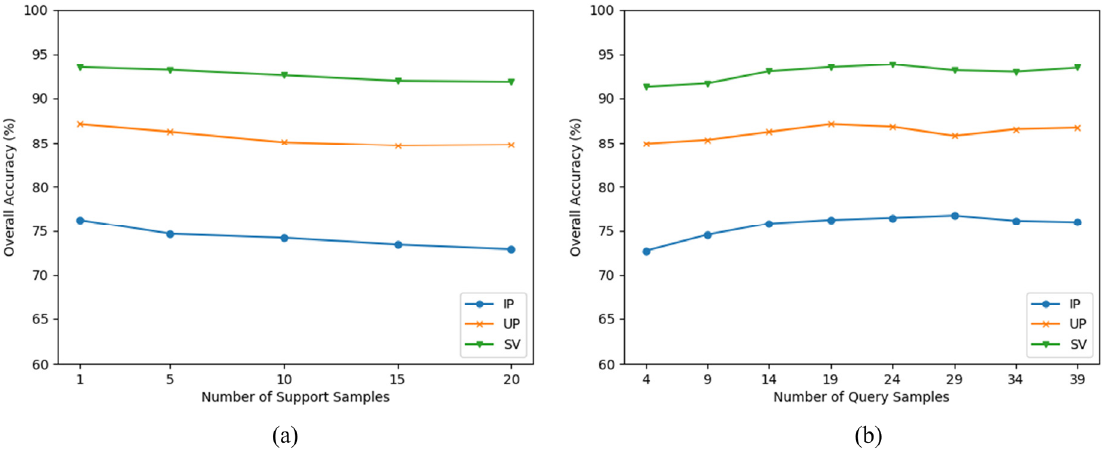
Figure 11. OAs obtained by GDAFSL with different size of task. ( a ) The number of support samples. ( b ) The number of query samples.